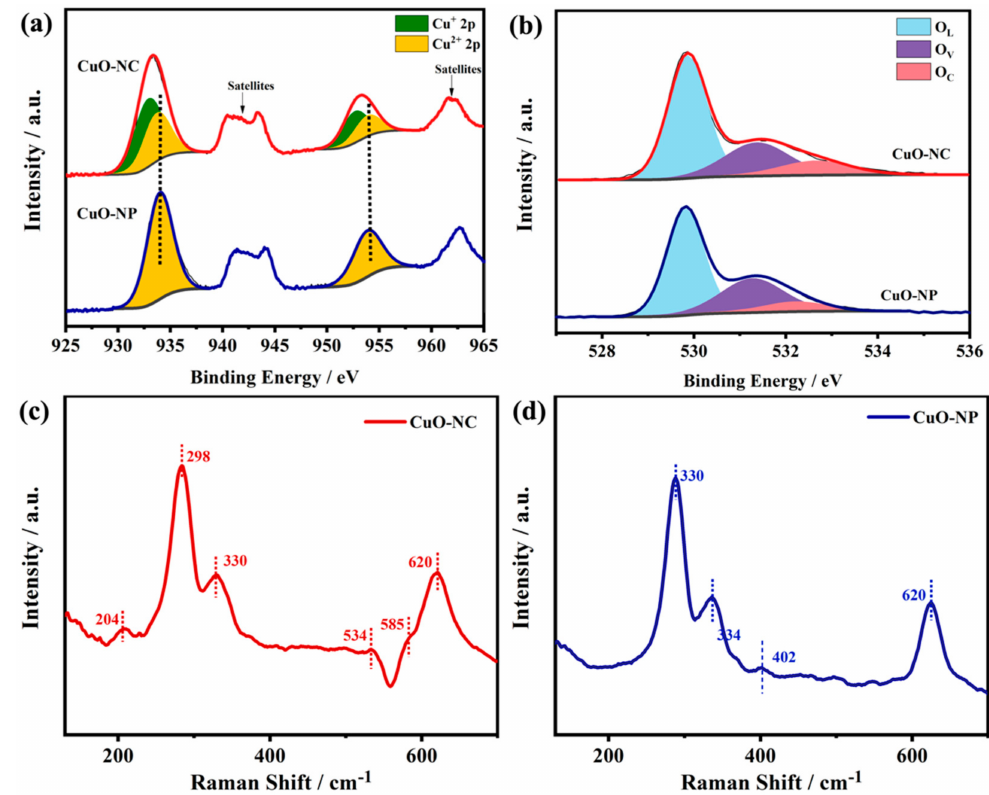
Figure 3. Chemical compositions of nano − CuOs. ( a ) Cu 2p XPS spectra, ( b ) O 1s XPS spectra, ( c ) Ra- man spectra and ( d ) EPR spectra of CuO − NC and CuO − NP. The inset of ( d ) is the correspondingly enlarged view of CuO −